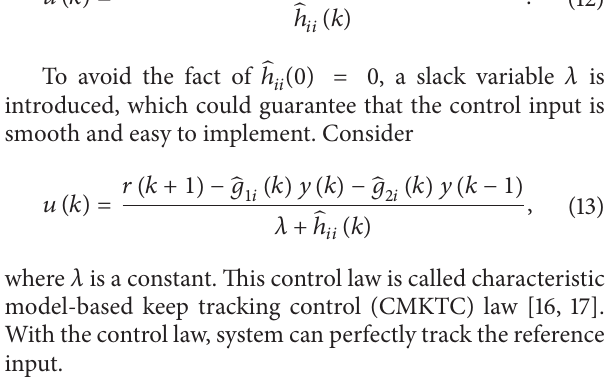
Figure 2: The schematic diagram of PZT